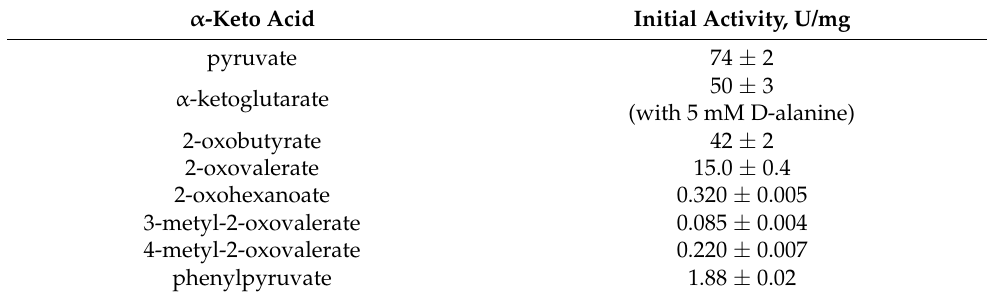
Table 3. The activity of Halhy in the overall reaction with D-glutamate and various α -keto acids. α -Keto Acid Initial Activity, U/mg pyruvate α -ketoglutarate